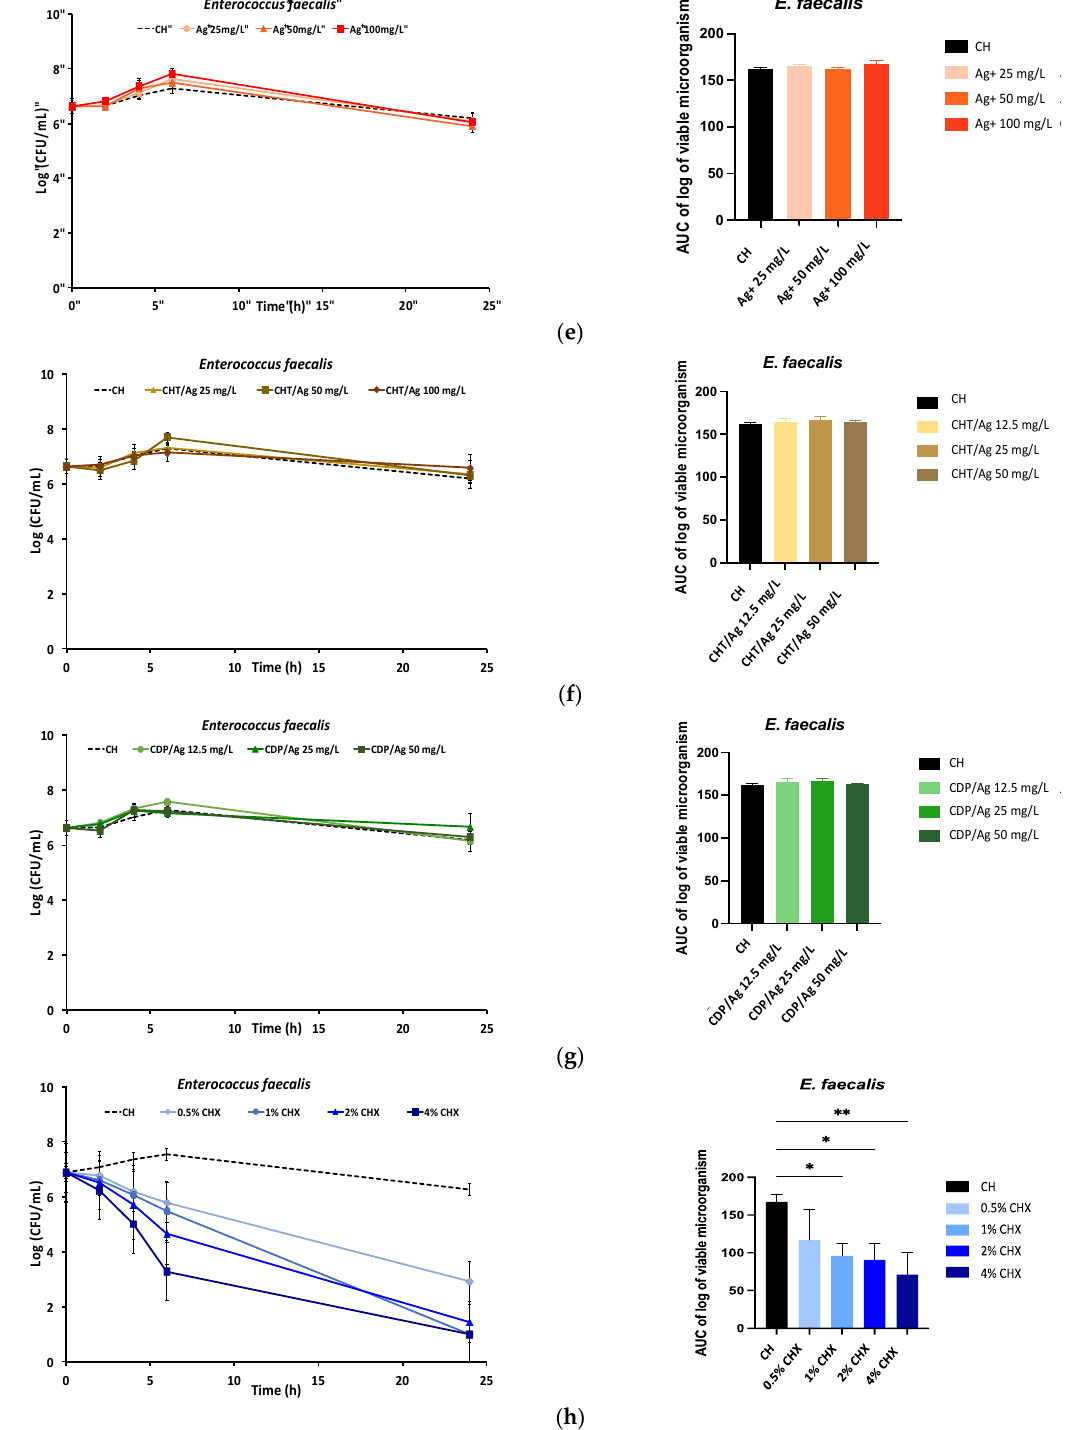
Figure 1. Time-kill kinetics curves and air under the curves (AUC) of the time-kill kinetics for Candida albicans ( a – d ) and Enterococcus faecalis ( e – h ) with calcium hydroxide (CH) alone (dotted line) compared to the mixtures ( a , e ): CH + silver solution (Ag+) 25 mg/L, 50 mg/L, 100 mg/L; ( b , f ) CH + silver as chitosan silver nanoparticles (CHT/Ag) 12.5 mg/L, 25 mg/L, 50 mg/L, 100 mg/L; ( c , g ) CH + silver as cyclodextrin polymer silver nanoparticles (CDP/Ag) 12.5 mg/L, 25 mg/L, 50 mg/L, and ( d , h ) CH + CHX solution 0.5% (5 × 10 3 mg/L), 1% (10 × 10 3 mg/L), 2% (20 × 10 3 mg/L), 4% (40 × 10 3 mg/L). (*): significant difference ( p < 0.05) and (**): significant difference ( p < 0.01) between the CH formulation and the test formulations (ANOVA